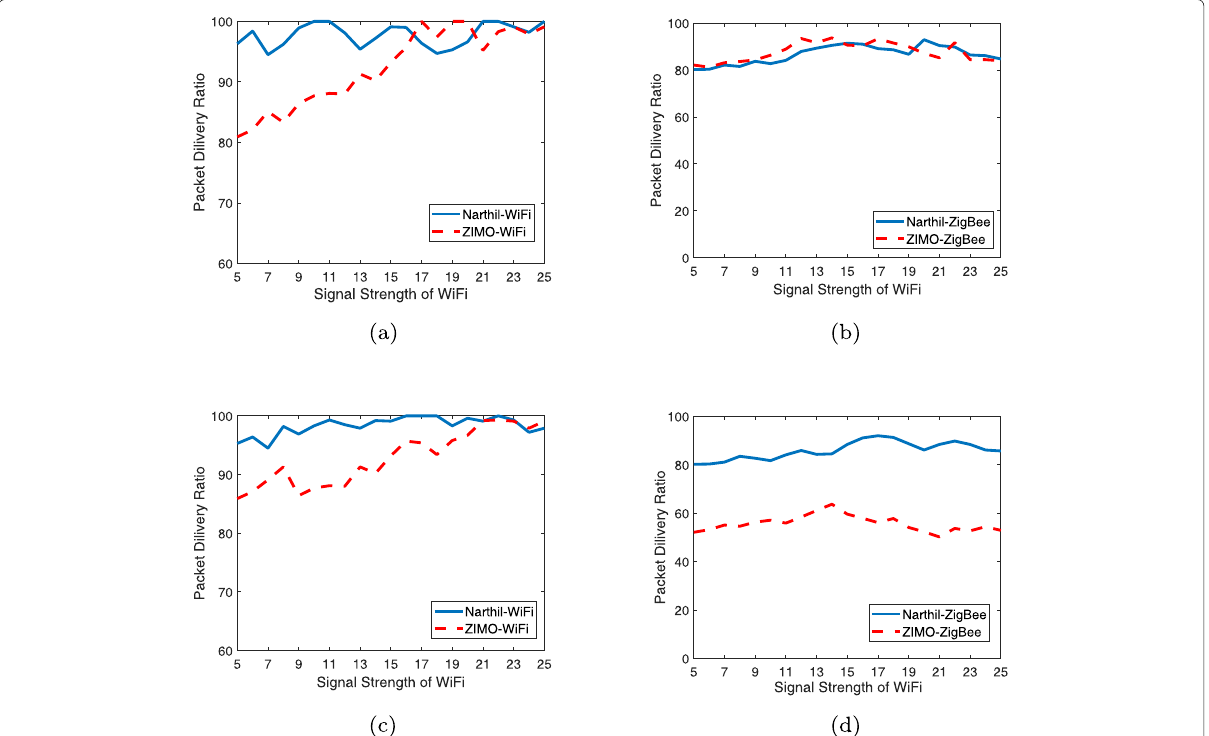
Fig. 22 Performance comparison with clean WiFi/ZigBee preamble. a WiFi decoding performance with clean WiFi preamble. b ZigBee decoding performance with clean WiFi preamble. c WiFi decoding performance with clean ZigBee preamble. d ZigBee decoding performance with clean ZigBee